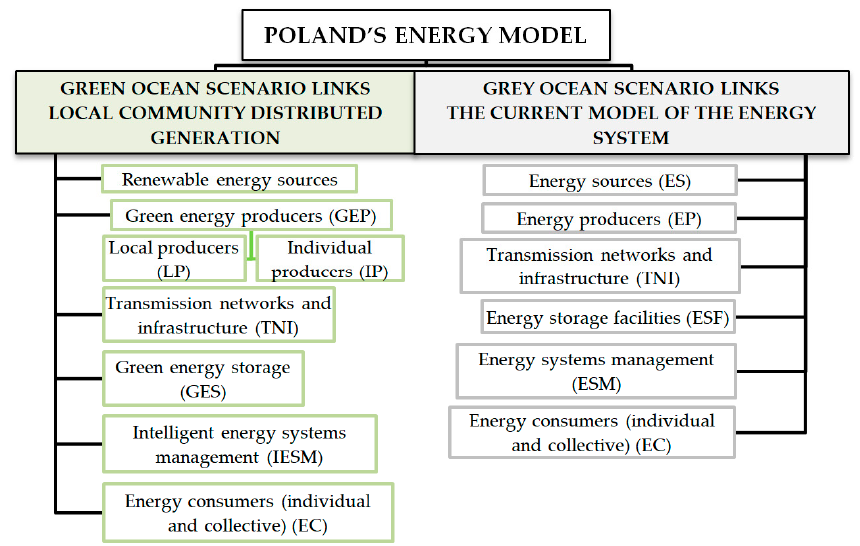
Figure 2. PES links in the Grey Ocean and Green Ocean scenarios. Source: own study.